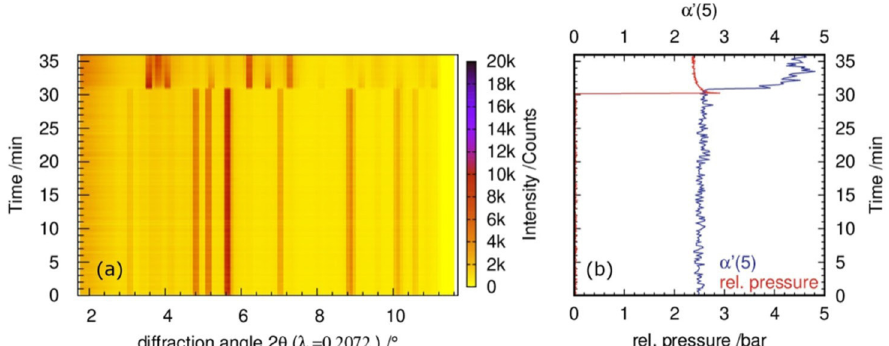
Figure 2. Real-time monitoring of the reaction of an equimolar mixture of zinc and sulphur being milled at a frequency of 27 Hz: ( a ) in situ PXRD synchrotron data and ( b ) pressure sensing data. The initial reaction time is confirmed using a calculated auto correlation parameter, α ’(5) [67].